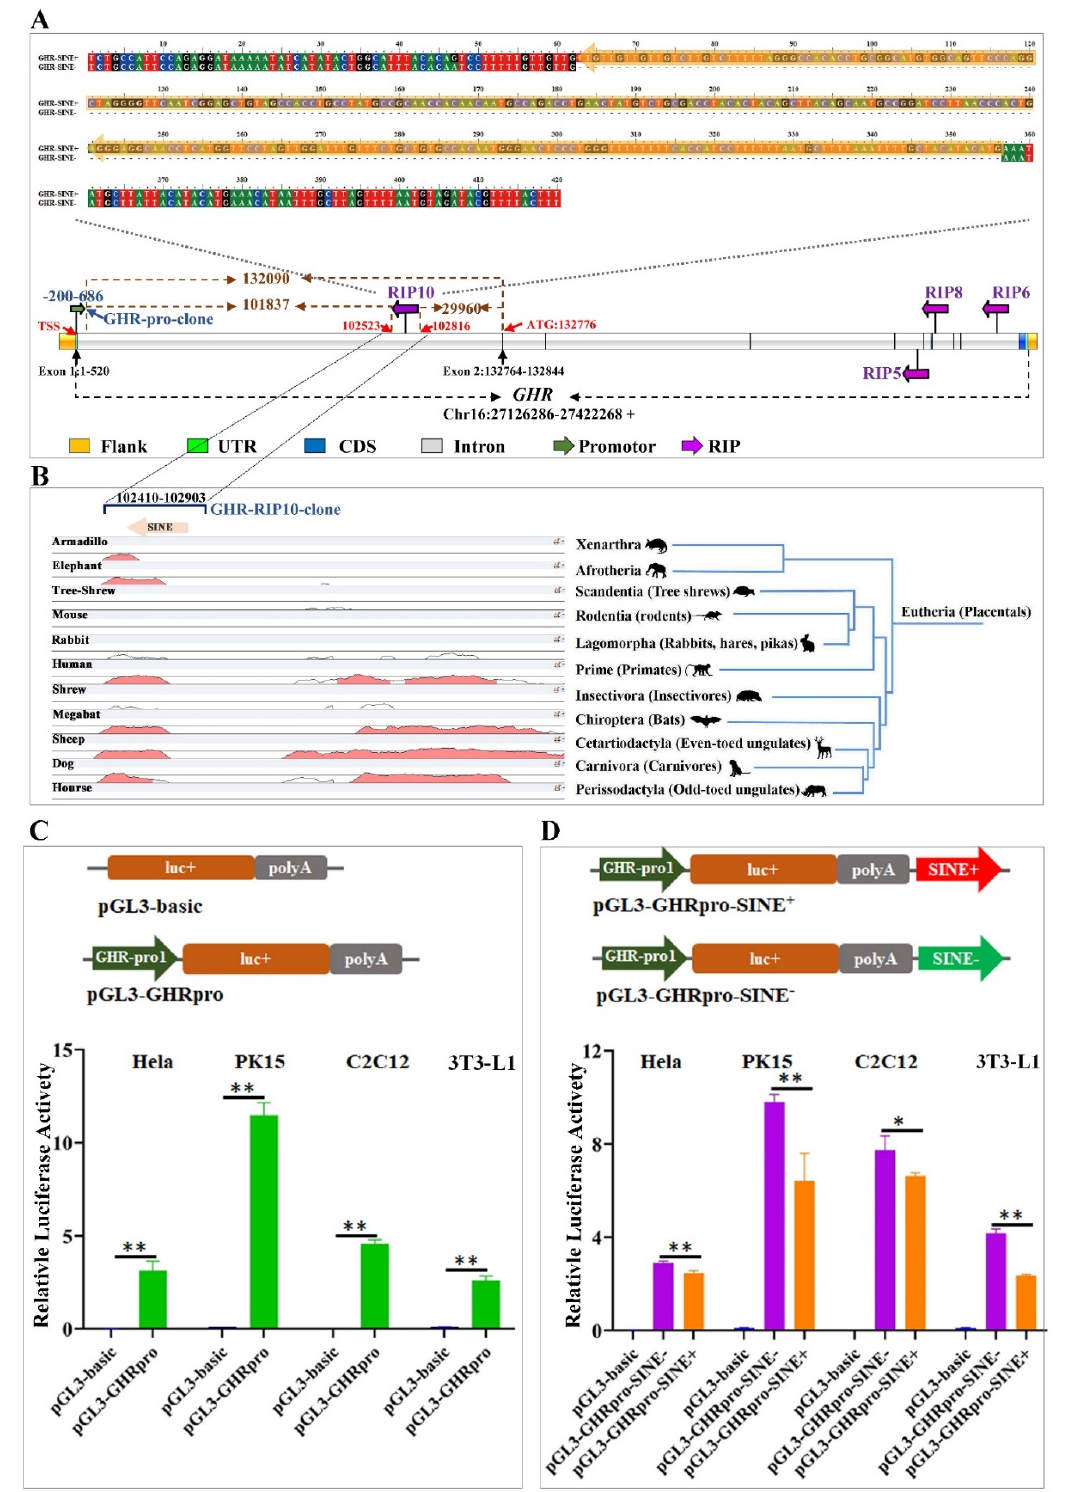
Figure 2. Effect of the GHR-RIP10 SINE insertion on GHR promoter activity. ( A ) The SINE sequence in GHR-RIP10 site with and without SINE insertion and its location on GHR gene. ( B ) The conservation analysis for the GHR-RIP10 locus. ( C ) GHR promotor detection results in Hela, PK15, C2C12 and 3T3-L1 cells by dual-luciferase reporter assay. ( D ) Impact of SINE insertion of GHR-RIP10 on the promoter activity of GHR by dual-luciferase reporter assay. * showed p < 0.05; ** showed p <